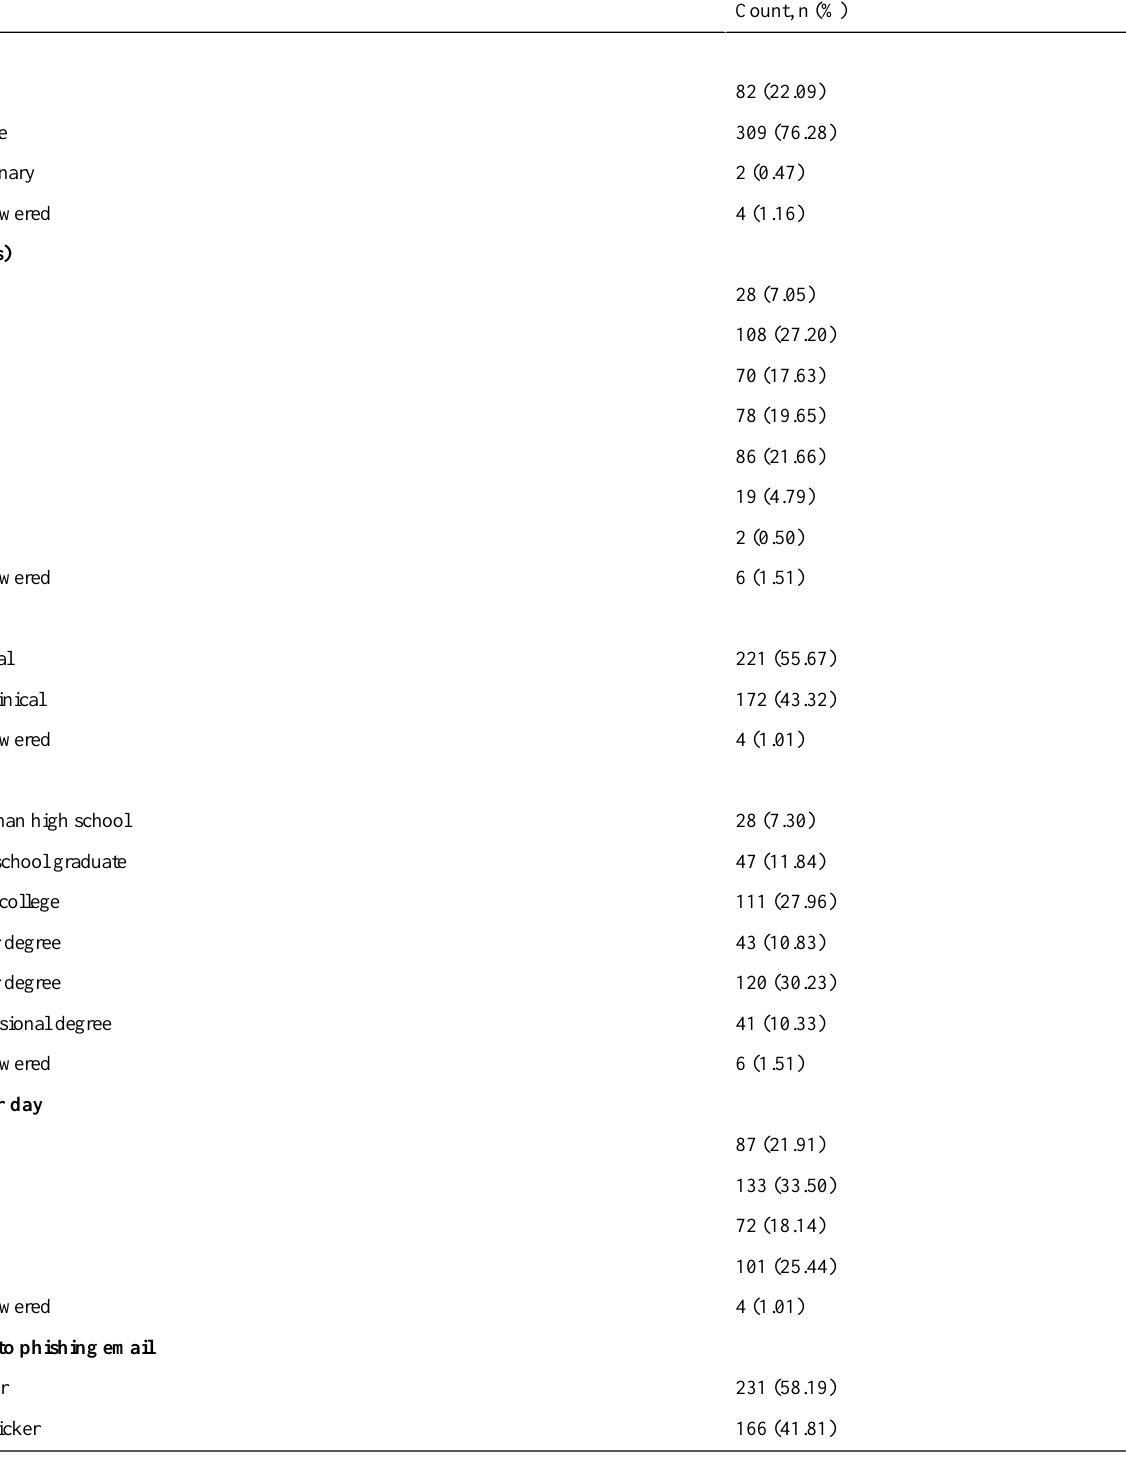
Table 3. Respondent characteristics